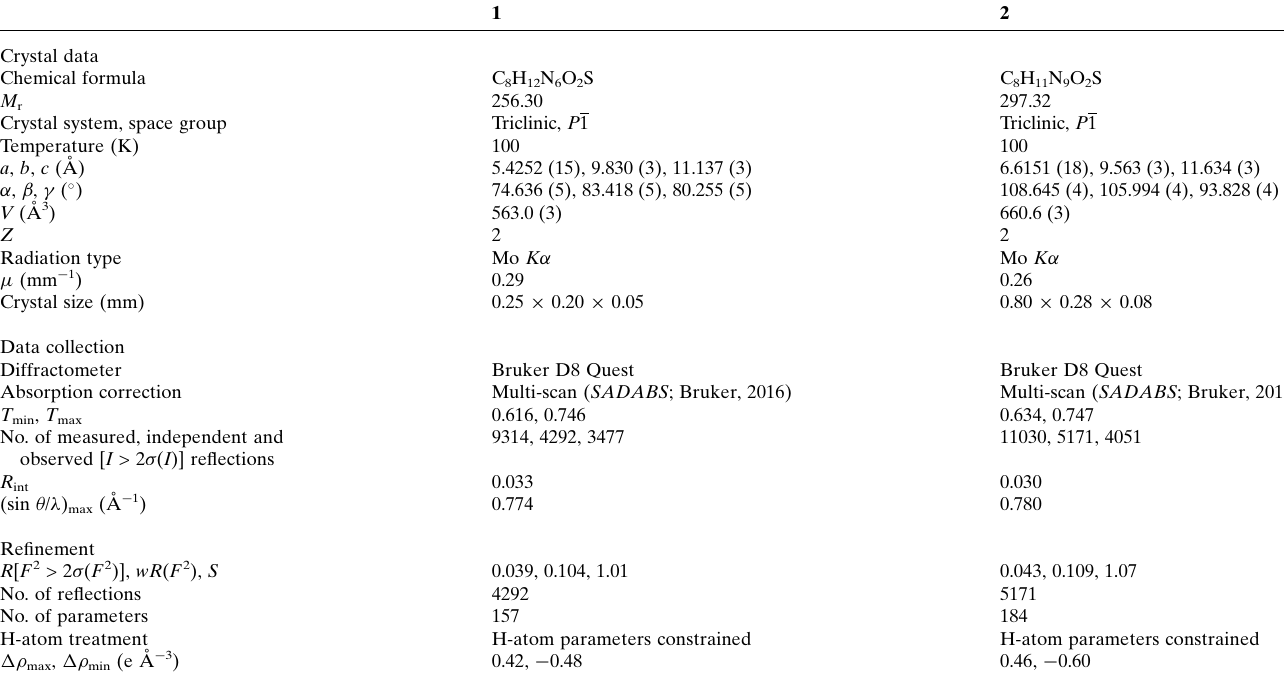
Table 3 Experimental details.